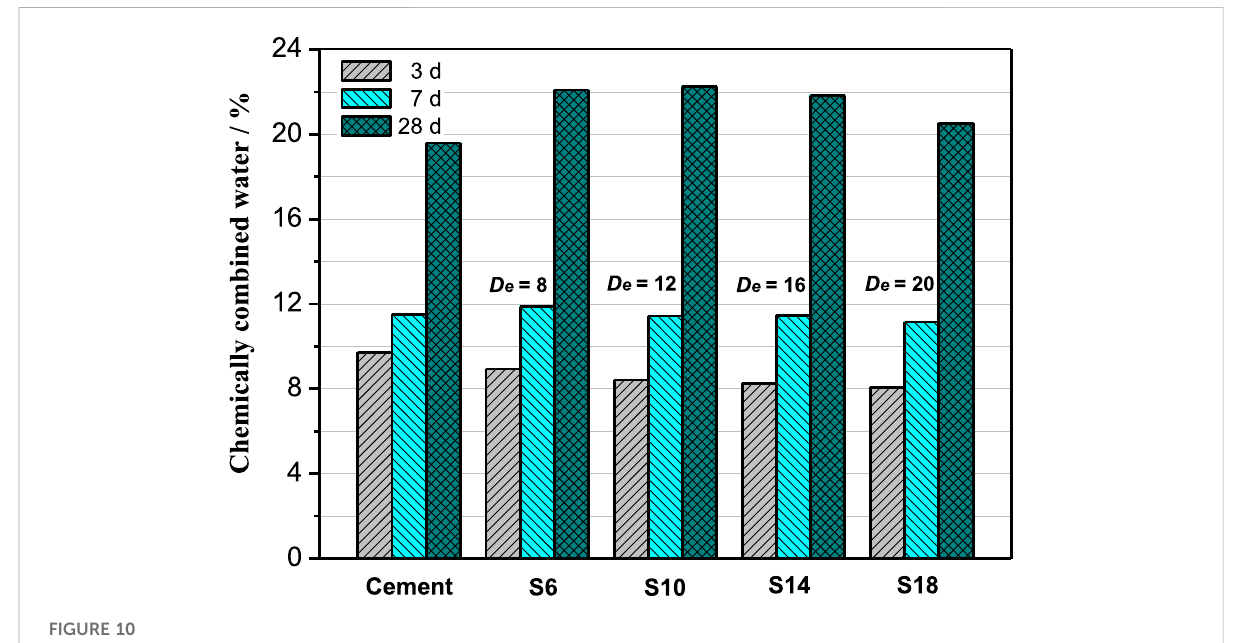
FIGURE 10 Chemically combined water of cement-GGBFS